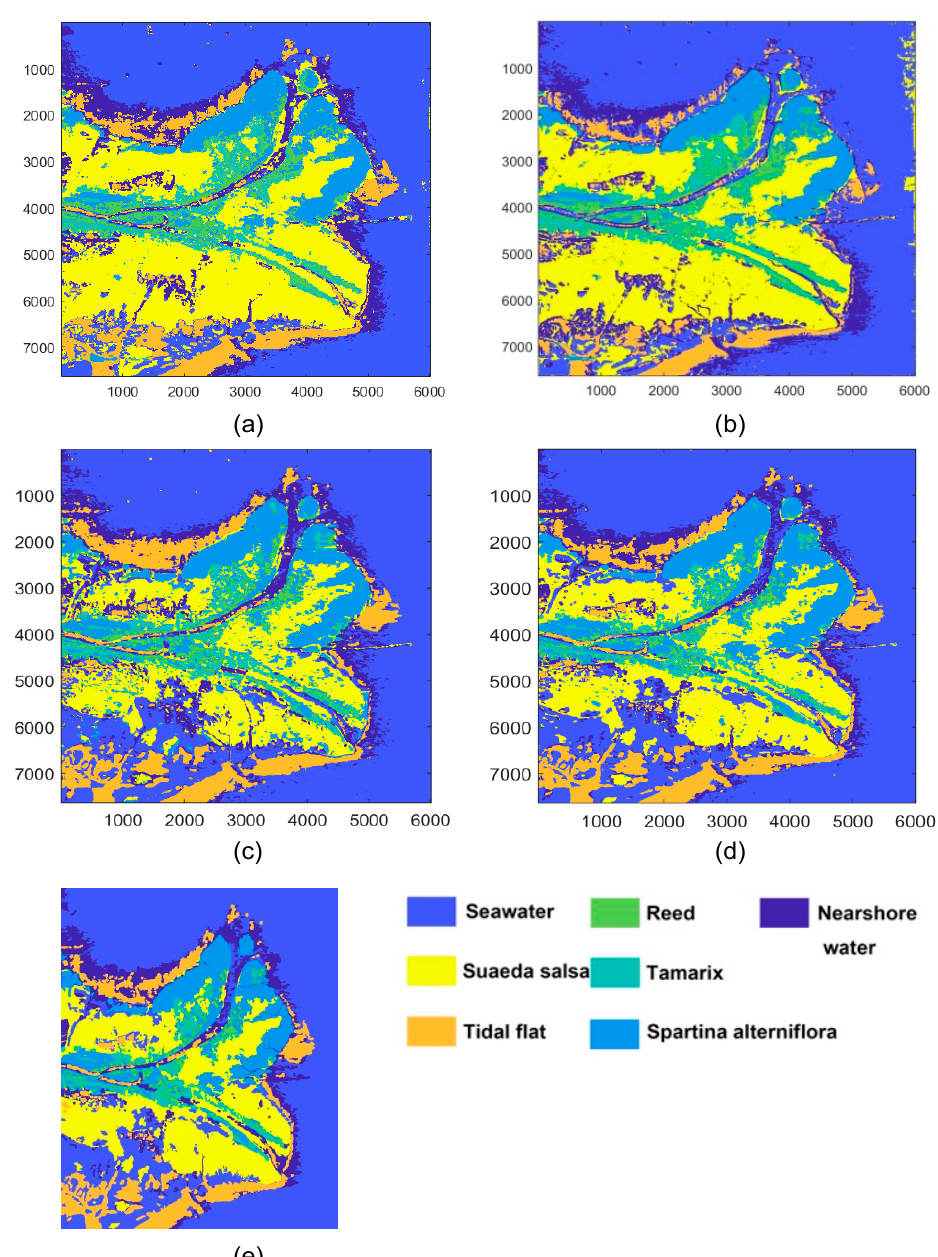
Figure 4. Results on AlexNet. ( a ) 4channels result, ( b ) 10 channels result, ( c ) 12 channels result, ( d ) 21 channels result, ( e ) Ground-truth map.